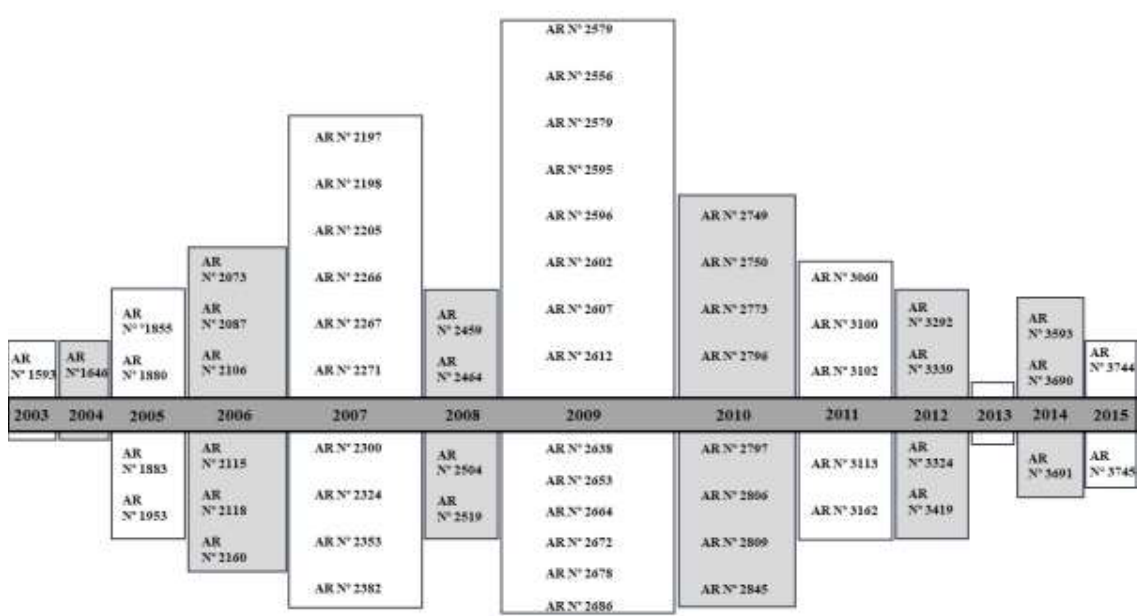
Figure 1. Administrative resolutions issued by the National Tax Agency in Argentina to control tax evasion in the grain market